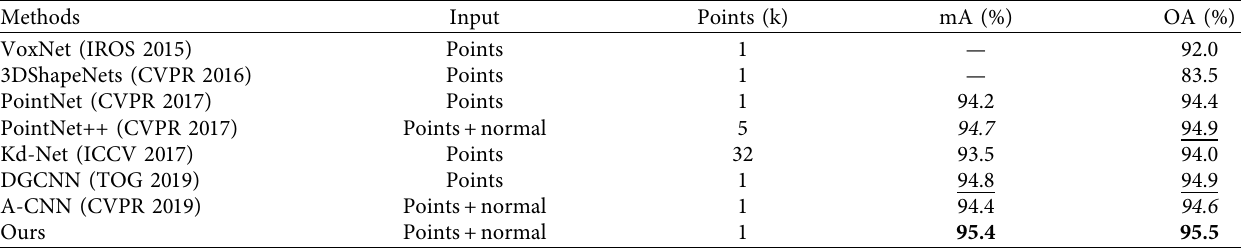
Table 2: Classification performance on ModelNet10. (The top three accuracies are highlighted by bold, underline, and italic.)